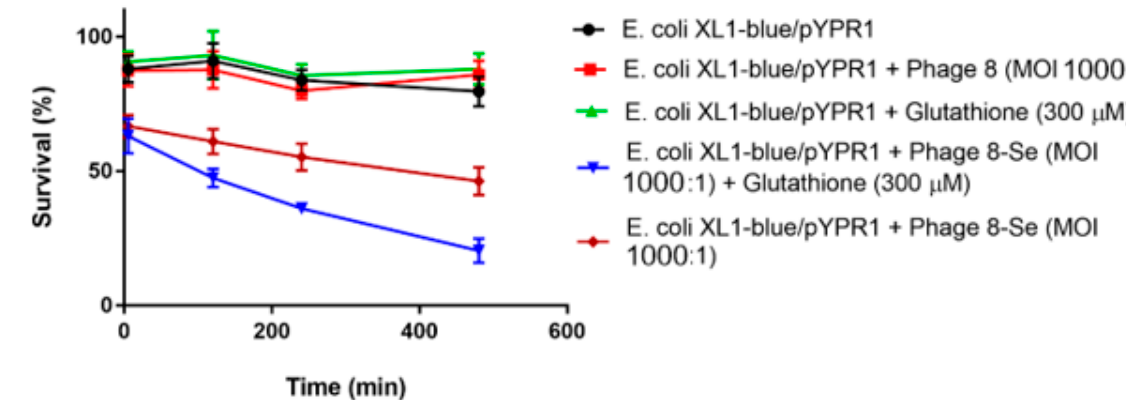
Figure 2. The effect of selenium-labeled phage #8 on the viability of E. coli XL1-blue/pYPR1. Survival of the Y. pestis F1-antigen-expressing E. coli XL1-blue/pYPR1 strain in the presence of selenium-labeled phage #8 at an MOI (multiplicity of infection) of 1000:1, with and without glutathione, at 150 or 300 µ M concentration. The XL1-blue/pYPR1 strain was incubated with selenium-attached phage #8, with and without reduced glutathione (150 or 300 µ M) in PBS. The control only had E. coli XL1-blue/pYPR1 in PBS. Other controls included XL1-blue/pYPR1 with either reduced glutathione or phage #8 in PBS. The experiments were carried out at room temperature for 8.5 h. After several time points, the aliquots of solutions were serially diluted and plated on LB agar supplemented with 100 µ g/mL carbenicillin, and c.f.u. was determined after overnight incubation. Values represent the results from two independent experiments. Multiplicity of infection (MOI) is the ratio of phage to bacteria.